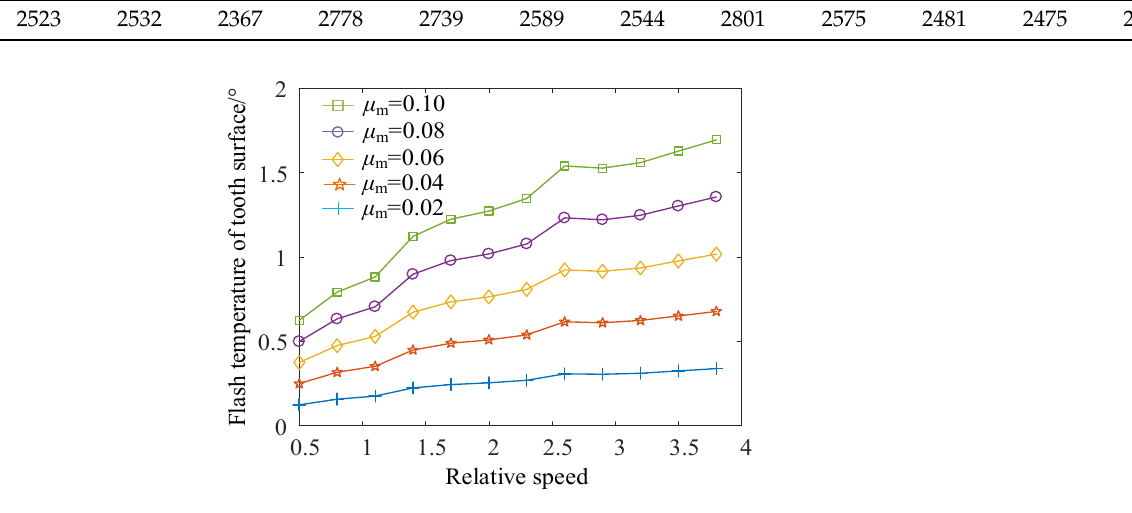
Figure 16. Tooth surface flash temperature with different μ m.